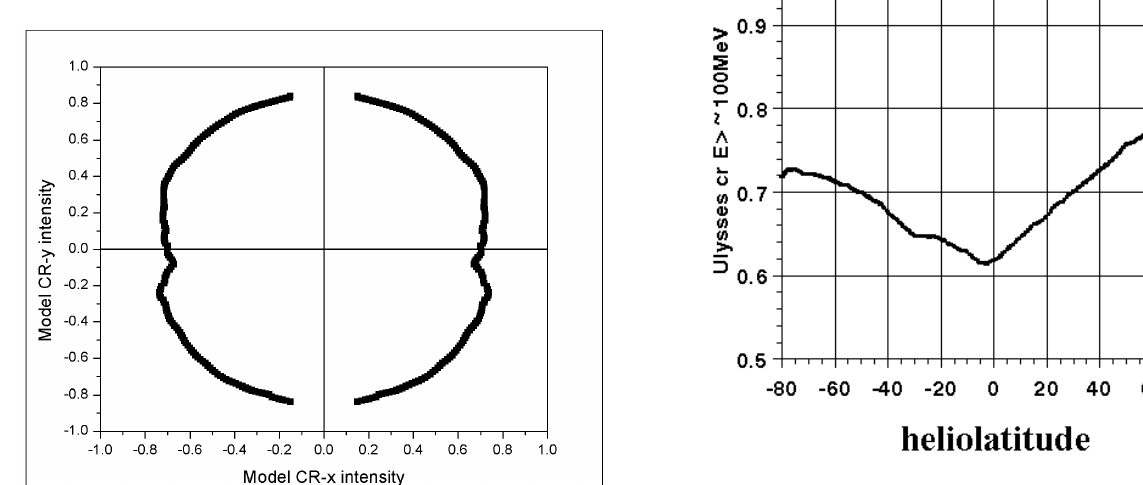
Fig. 2b. The heliolatitudinal profile of the cosmic-ray intensity ob- tained from the model for γ 1 = 1 . 0 e − 5 and δ = 10.